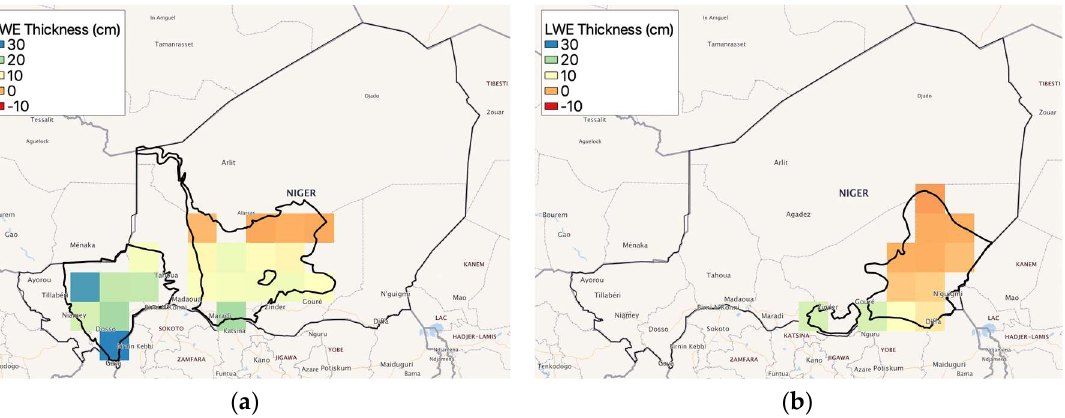
Figure 9. Raster maps of groundwater storage anomaly for the Iullemeden basin aquifers (panel ( a ) and the Lake Chad basin aquifers (panel ( b ) for April, 2021.